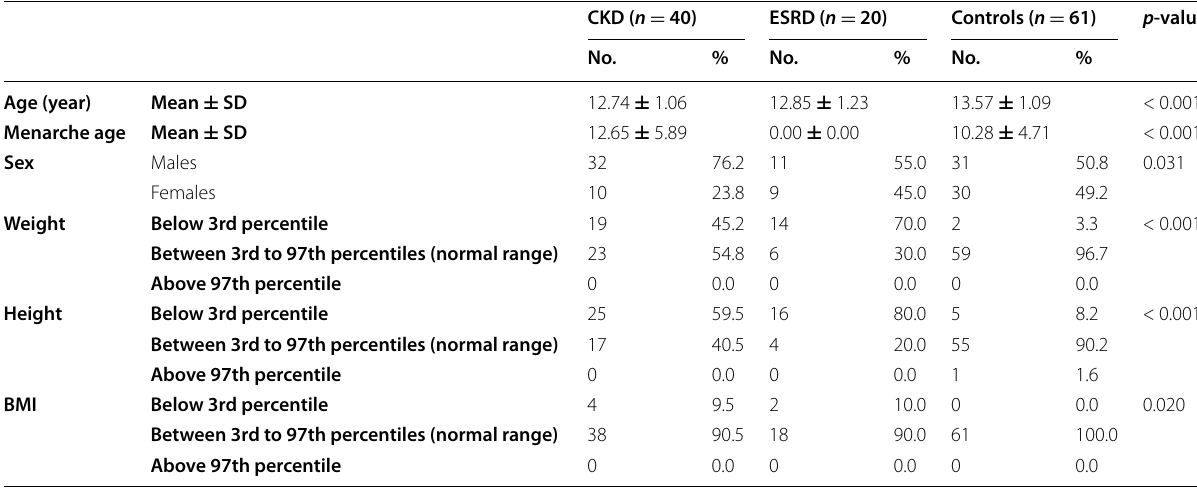
CKD chronic kidney disease, ESRD end-stage renal disease